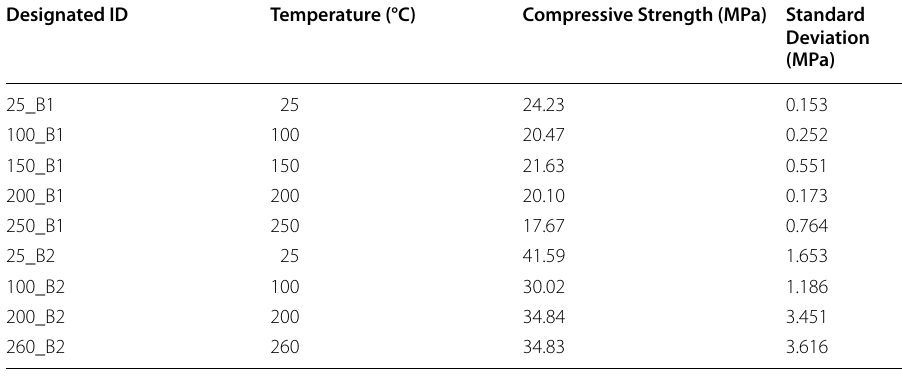
Table 1 Average compressive strength of all test specimens